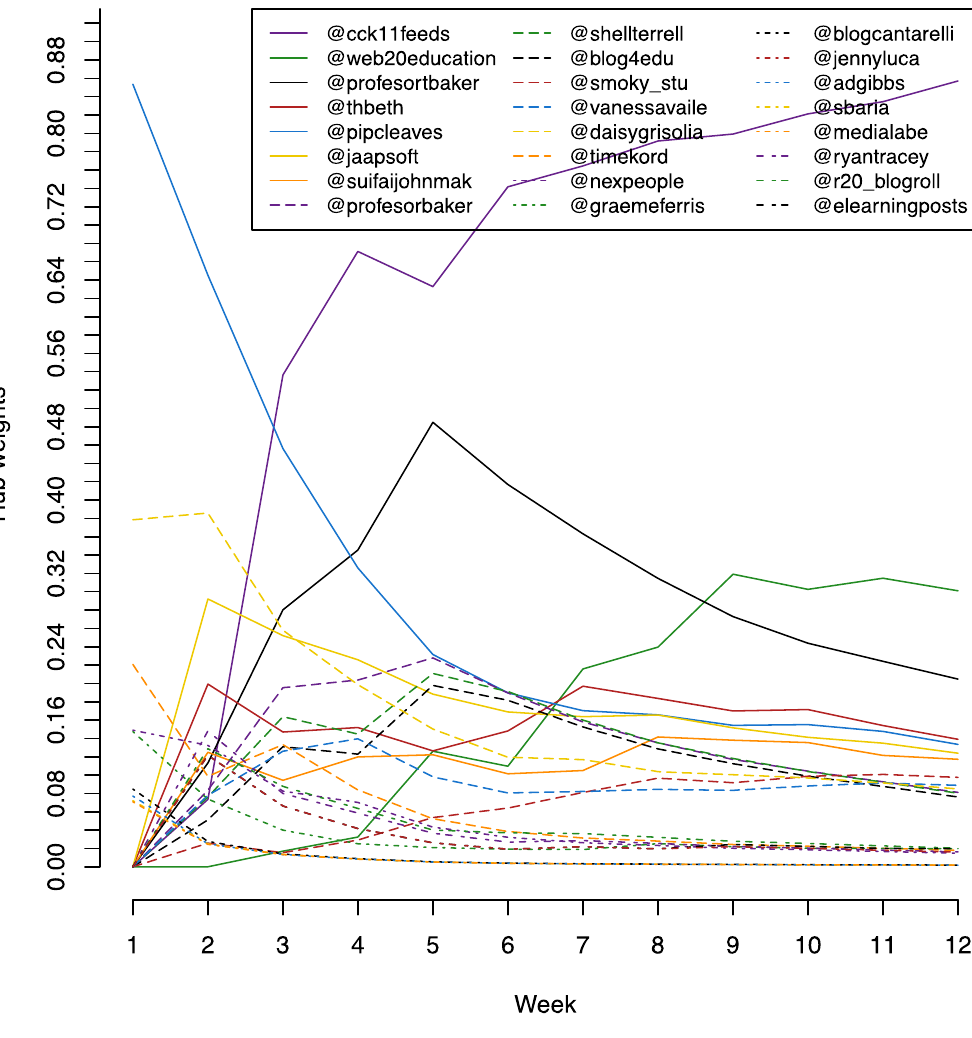
Figure 4. Variation of the hub weights for the top ranked nodes, over the twelve weeks of the